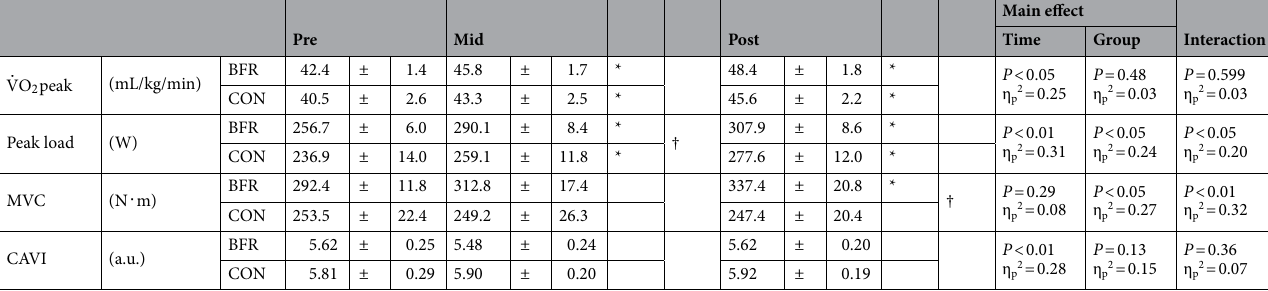
˙ VO2peak Table 2. Changes in peak oxygen uptake ( ), peak load, maximal voluntary contraction (MVC) torque in knee extensors, and cardio-ankle vascular index (CAVI) before (Pre), 4 weeks after (Mid), and 8 weeks after (Post) cycle training with (BFR group) or without (CON group) blood flow restriction (BFR). Statistical analysis was performed using a repeated-measures two-way analysis of covariance followed by Bonferroni’s multiple comparisons test. Partial eta squared (η p 2 ) is the effect size of the interaction and main effects of group and time. Values are expressed as mean ± SE (n = 9). *Significant difference from pre-training (Pre) ( P < 0.05). †Significant difference between BFR group and CON group at that time point ( P < 0.05).